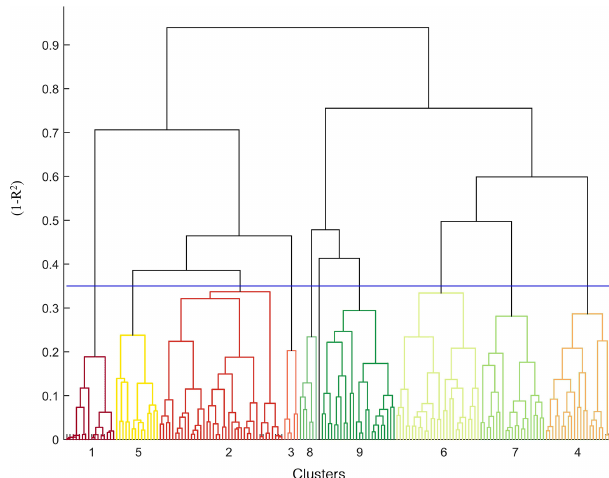
Figure 6. Dendrogram results: cluster colours are the same as in Fig. 7, for better identification. The numbers on the x axis are the cluster numbers. The y axis is (1 − R 2 ), where r is the correlation coefficient between FTBA and DSRp. The blue line is the clustering threshold at 0.35. Each vertical line is a municipality.